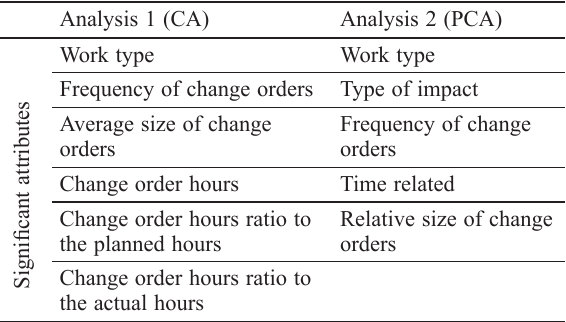
Table 3. Summary of training data